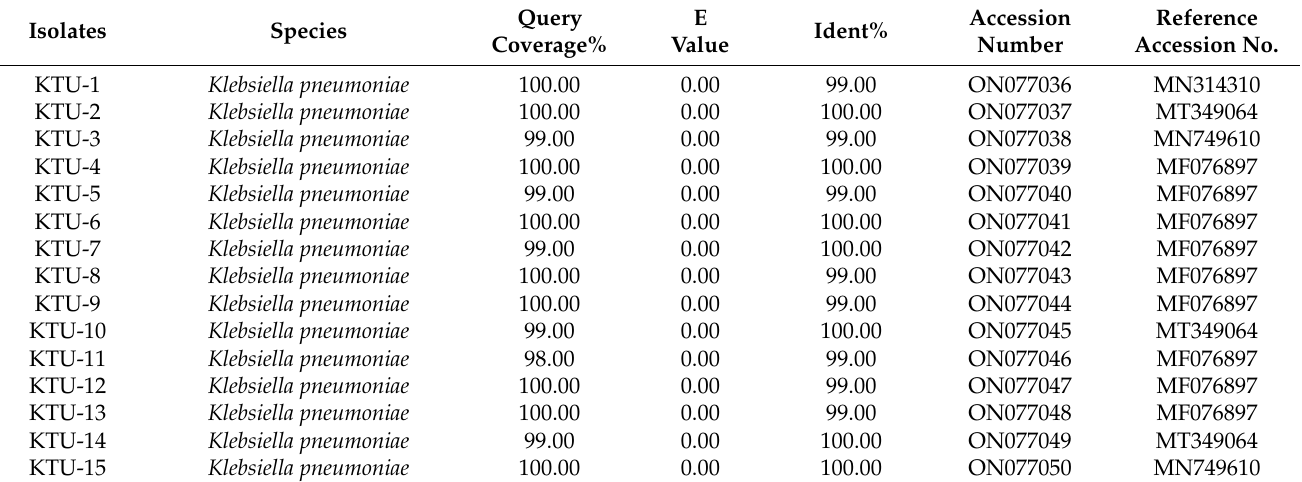
Table 2. NCBI BLAST query for Klebsiella pneumoniae isolated from invertebrates in Taif, Saudi Arabia.